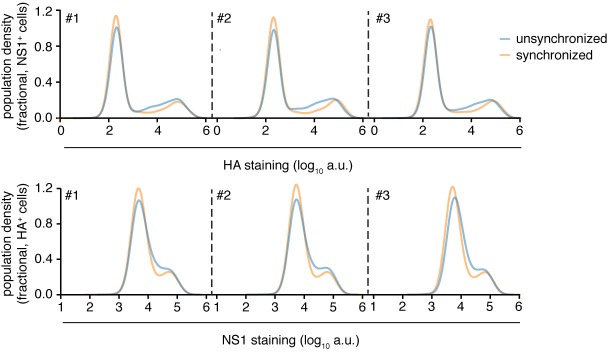
Synchronization of infection does not greatly affect heterogeneity.Flow cytometry analysis of expression of viral proteins in cells infected at an MOI of 0.1 (unsynchronized) or 0.2 (synchronized) as calculated by TCID50 on MDCK-SIAT1 cells. The higher MOI for synchronized infections was to attempt to account for loss of virus in washing steps. Infections were synchronized by pre-adsorbing virus at 4∘C for 1 hr prior to initiation of infection by shifting temperature to 37∘C using pre-warmed media. Cells were concurrently stained for HA and NS1 proteins at 10 hr after initiation of infection, and then analyzed by flow cytometry. The level of HA protein was quantified in cells that were identified as infected based on being positive for NS1 protein (top), and the level of NS1 protein was quantified in cells that were identified as infected based on being positive for HA protein (bottom) Synchronization resulted in a small decrease in variability in the levels of each viral protein, particularly in cells with intermediate levels. But the effects were small compared to the overall variability in the protein levels, indicating timing of infection makes only a small contribution to the observed heterogeneity. Data are shown for three independent replicates.